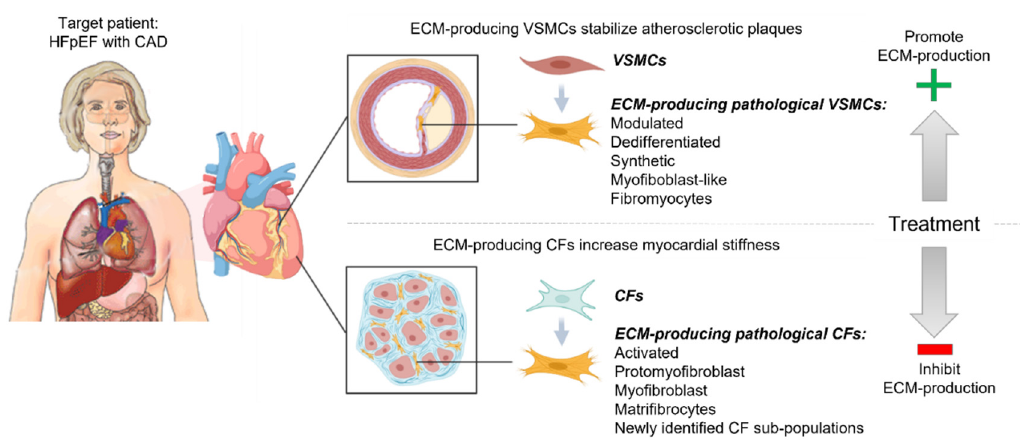
Figure 1. Dual roles of fibrotic remodeling in cardiovascular disease. Targeting ECM remodeling to reduce cardiac fibrosis in patients with Heart Failure with Preserved Ejection Fraction (HFpEF) and atherosclerosis-driven coronary artery disease (CAD) may entail a risk of destabilizing coronary atherosclerotic plaques, thereby causing myocardial infarction (MI). Cardiac fibroblasts (CFs)